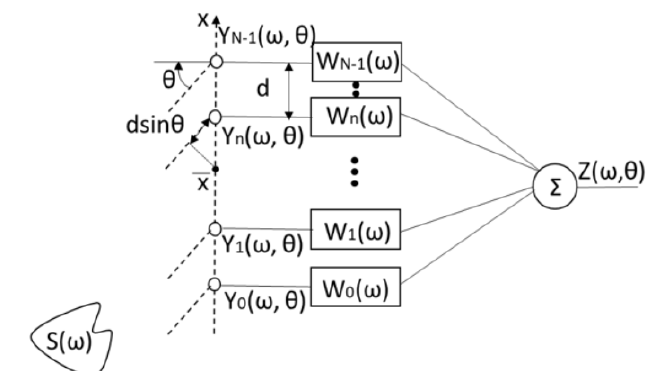
Figure 1. Beamforming with a linear microphone array